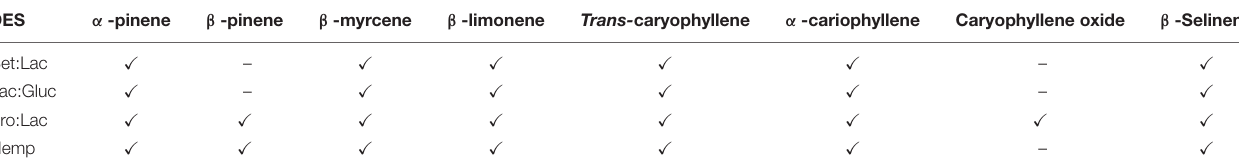
TABLE 5 | Identification of the terpenes present in DESs extracts by GC-MS/SPME. DES α -pinene β -pinene β -myrcene β -limonene Trans- caryophyllene α -cariophyllene Caryophyllene oxide β -Selinene